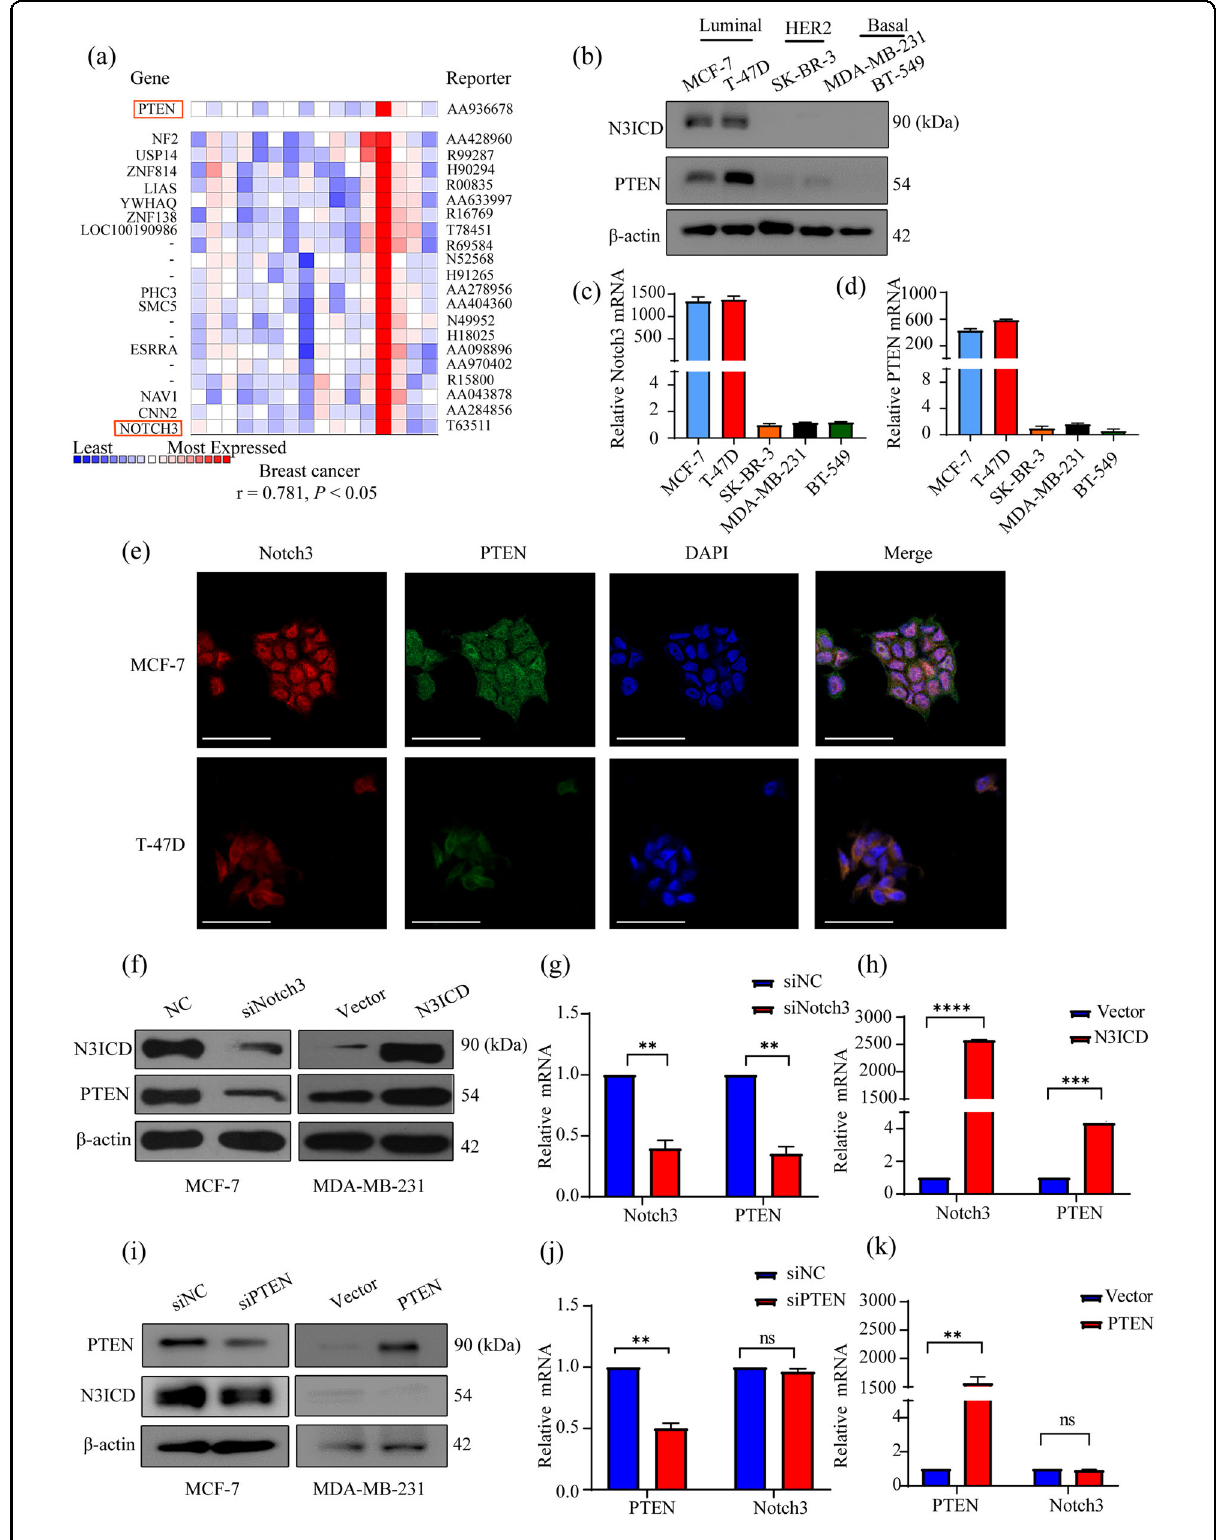
Fig. 1 (See legend on next